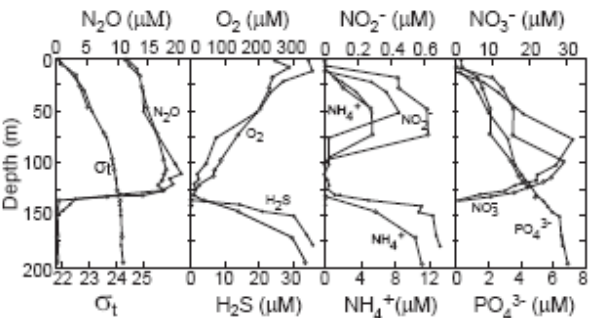
Fig. 12. Vertical profiles of (a) density ( σ t ) and N 2 O; (b) O 2 and